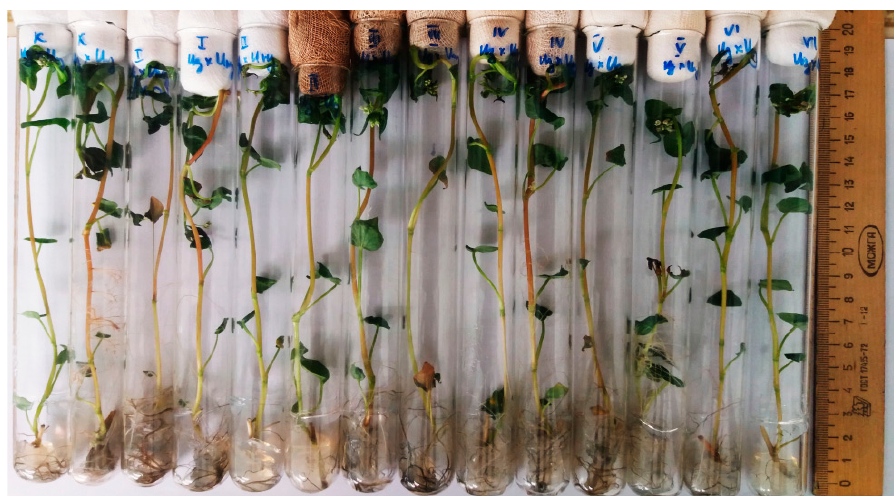
Figure 4. Buckwheat regenerants (hybrid Izumrud × Inzerskaya, variants following treatment with 808–1313 mg L − 1 of zinc salt), IV passages on the MS.